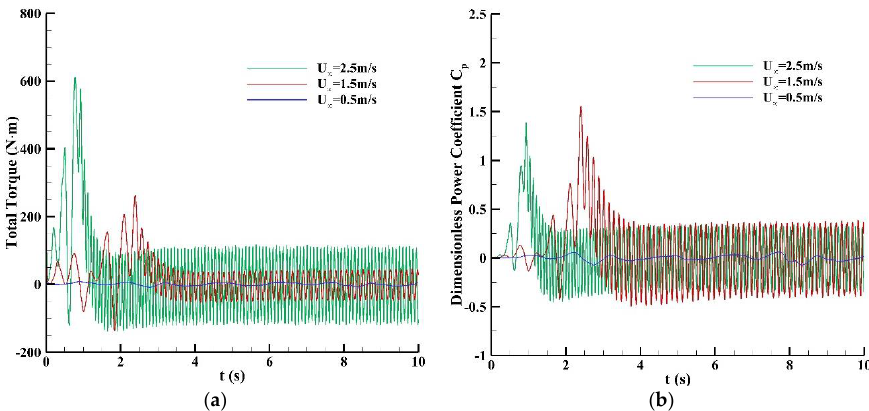
Figure 6. Effects of the incident free velocity on the hydrodynamic performance (No-load condition): ( a ) Torque; ( b ) C p .